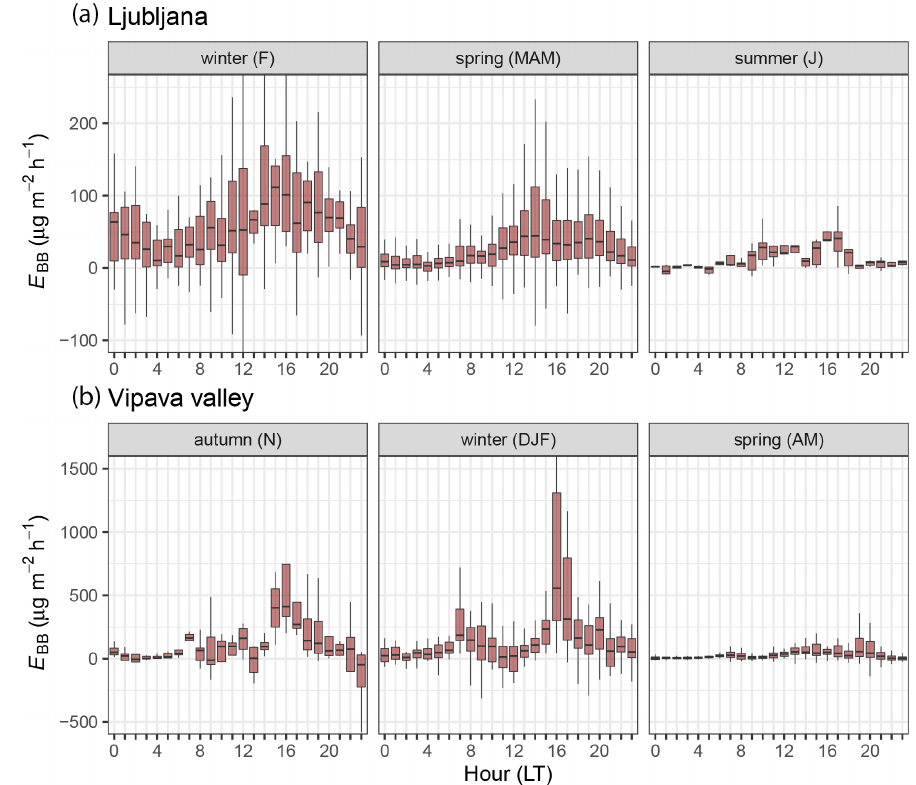
Figure 11. Diurnal variation (local time: CET/CEST) in emission rate of biomass-burning-related BC ( E BB ) in Ljubljana (a) and Vipava valley (b) , grouped by season (note the different scales). The statistics for every hour in a day are represented by a box plot (horizontal line: median; brown-coloured box: 25th–75th percentiles; whiskers: 5th–95th percentiles).